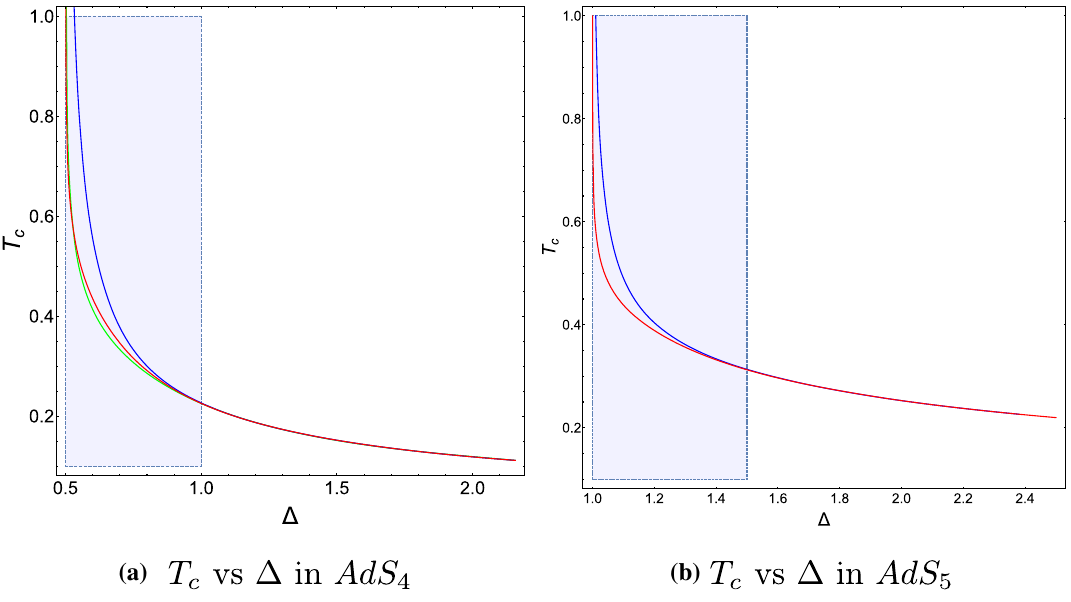
Fig. 2 a Shaded area should be eliminated due to the non-uniqueness shaded area at 1 ≤ (cid:2) < 3 / 2 should be eliminated in AdS 5 due to the of eigenvalues λ g , 3 shown in a , b at Fig. 1. This naturally eliminates non-uniqueness of eigenvalues λ g , 4 . This naturally eliminates (cid:2) = 1 (cid:2) = 1 / 2 where T = ρ = 1. b Similarly, where T c diverges. There are two branches in AdS 5 unlike AdS c diverges. We have set g